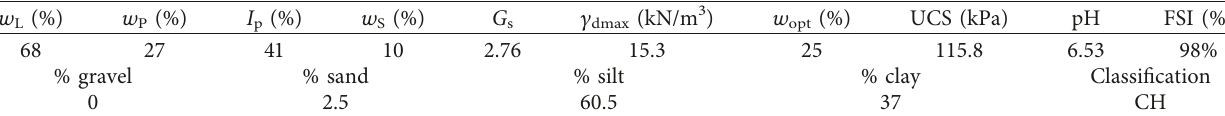
Figure 1: Materials adopted in the study: (a) soil, (b) lime, and (c) BA. Table 1: Properties of